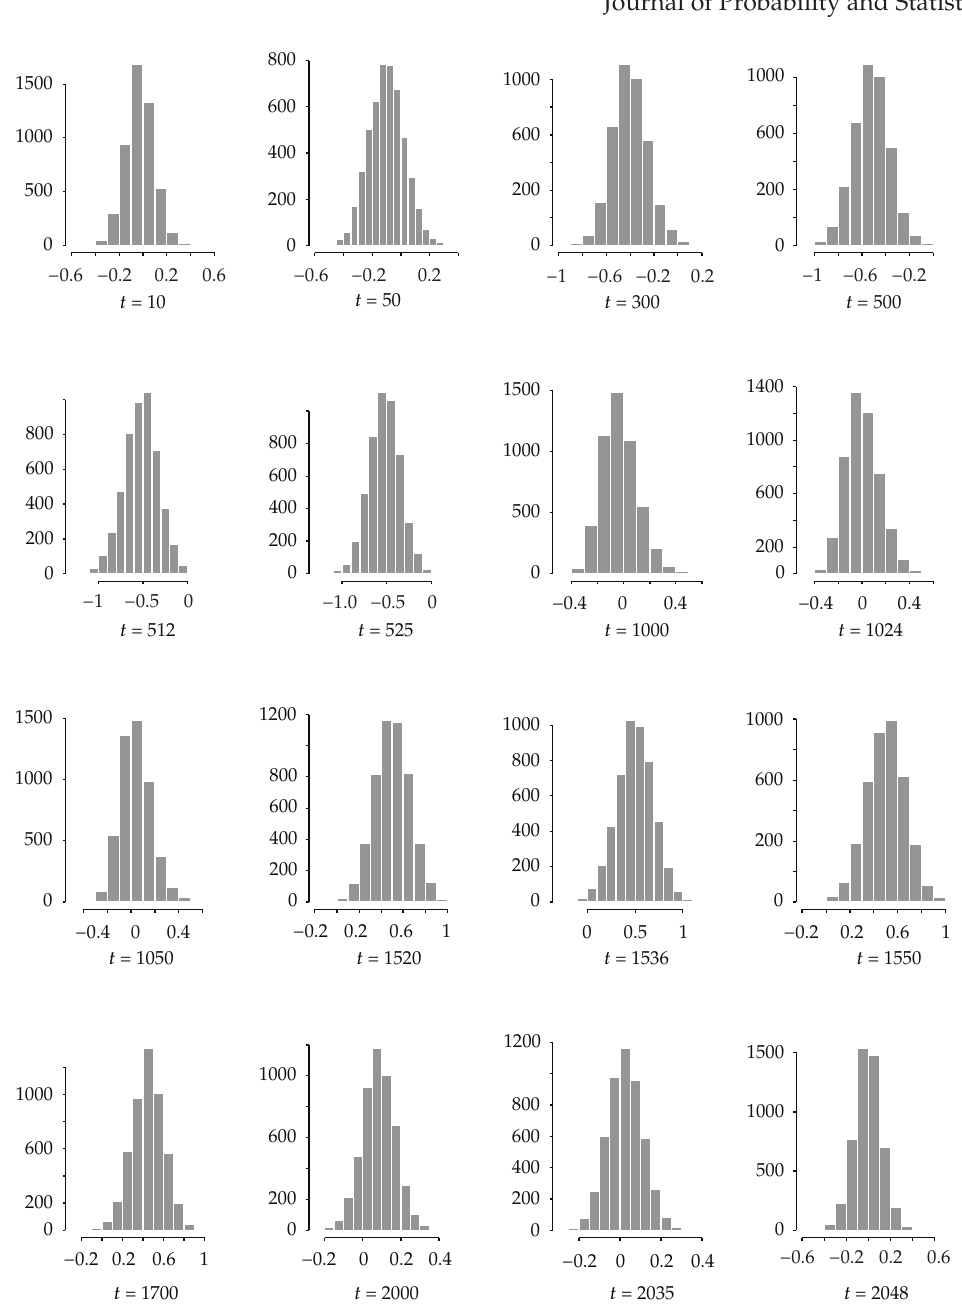
Figure 17: Example 5.1: Histograms of linear estimate of δ 1 at some points of (cid:7) 0,1 (cid:8)